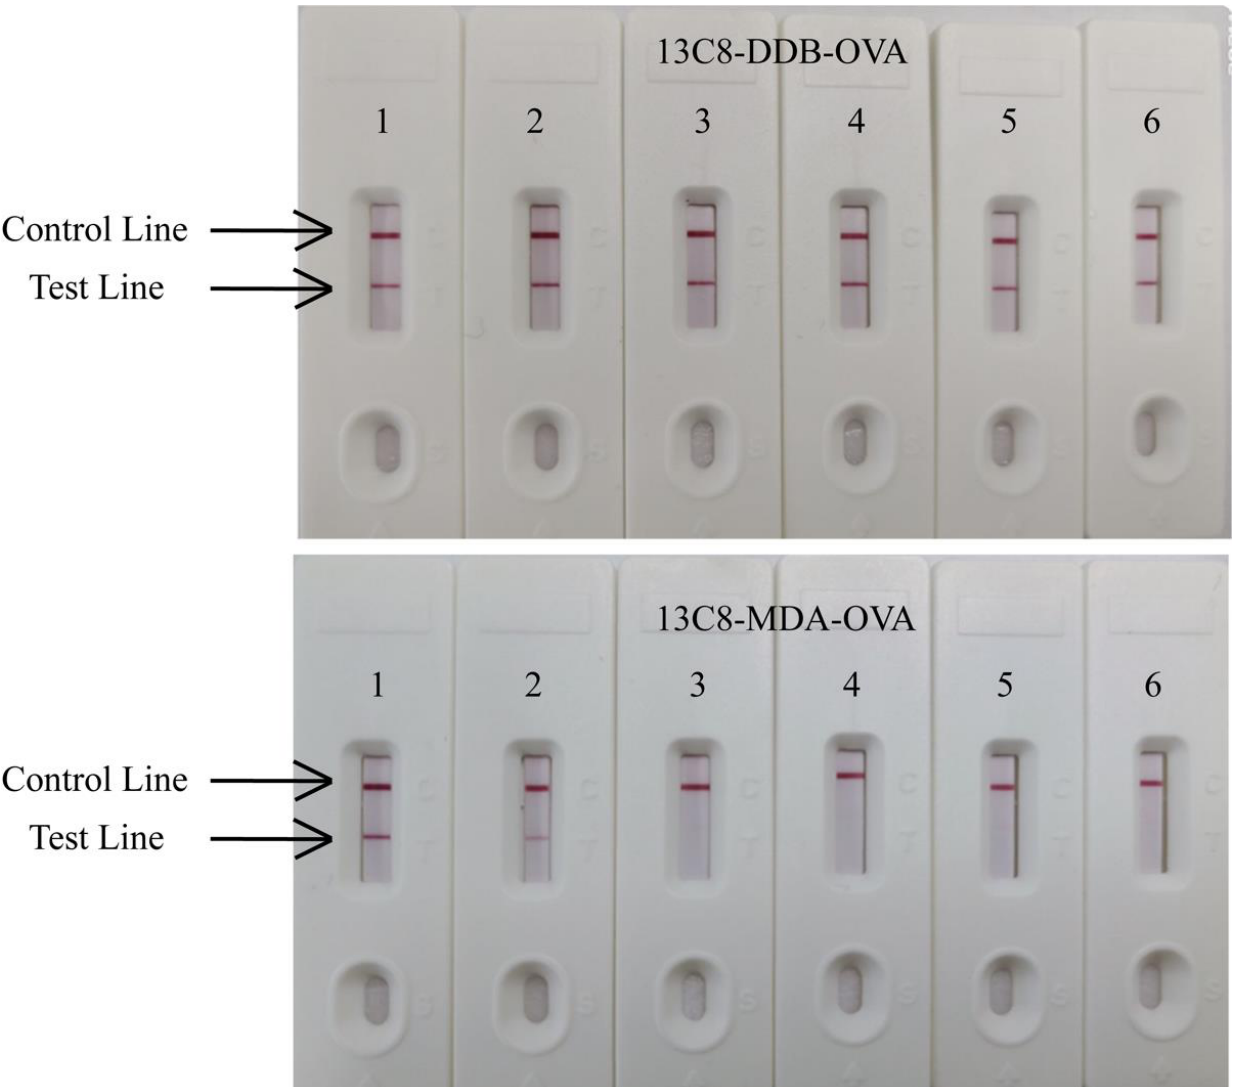
Figure 3. The sensitivity of colloidal gold-based lateral flow immunoassay for carbofuran with 13C8 and different coating antigens. 1 = 0 ng/mL, 2 = 1 ng/mL, 3 = 3 ng/mL, 4 = 5 ng/mL, 5 = 100 ng/mL, 6 = 1000 ng/mL.